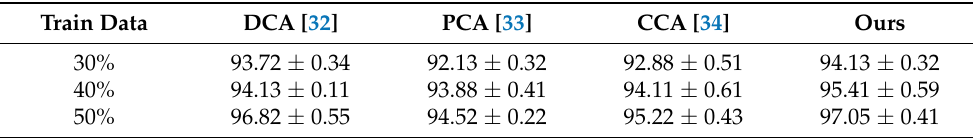
Table 3. Comparison of classification accuracy (%) with feature-level fusion methods under different training sizes on the WHU-RS dataset.